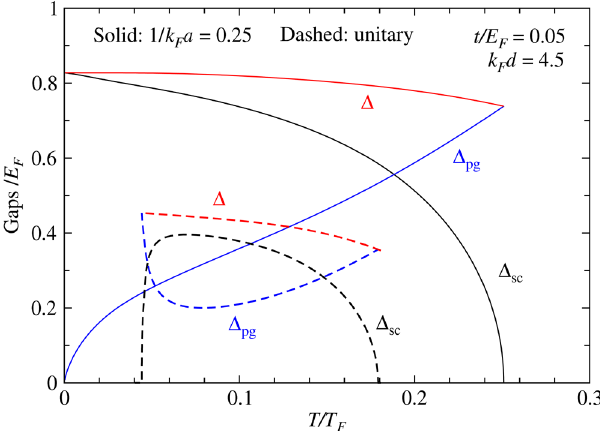
Figure 5. Fraction of the 3D component outside the first Brillouin zone along the T c curves with = . t E / 0 1 different values of k F d . The inset plots the fraction at T c as a function of k F d at unitarity. The fraction increases with k F d but vanishes for all cases in the BEC regime.